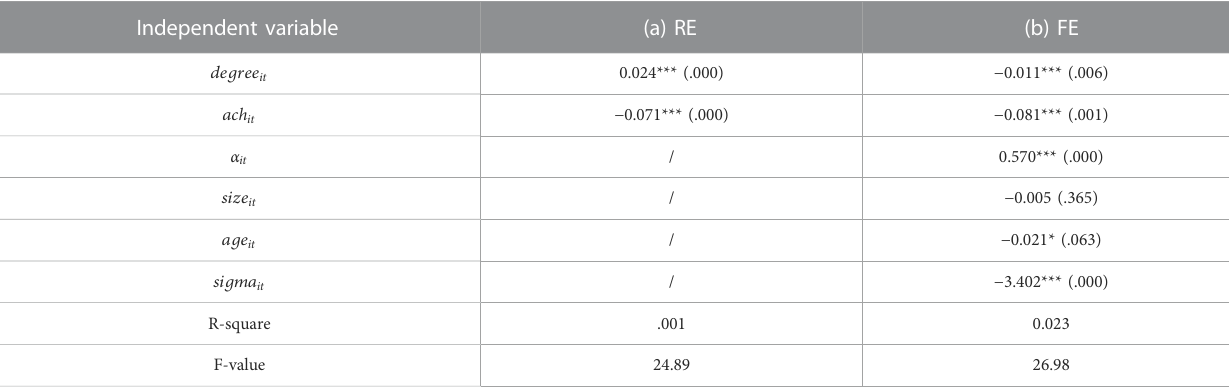
TABLE 3 Regression results of model (3). Independent